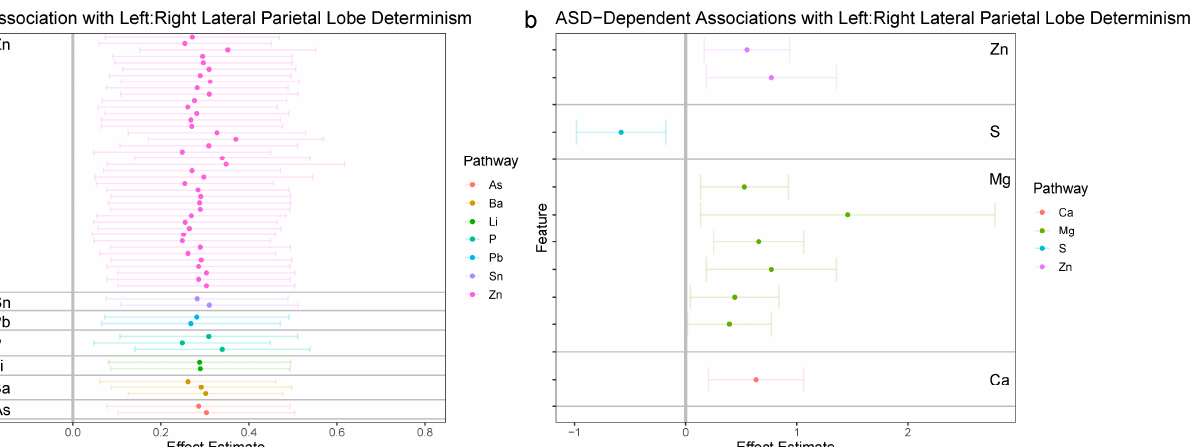
Figure 4. Associations between elemental dynamics and synchronization between medial prefrontal cortex and right lateral parietal lobe. ( a ) Left panel shows effect estimates for associations between elemental features and determinism in the LP R and MPFC BOLD signals; only features with significant associations following FDR-adjustment for multiple comparisons are shown. ( b ) Right panel shows effect estimates for the interaction between autism and features of elemental dynamics; features with significant associations following FDR-adjustment for multiple comparisons are shown. The magnitude of effect estimates in essence depicts the difference in a given feature between participants with autism and control participants.